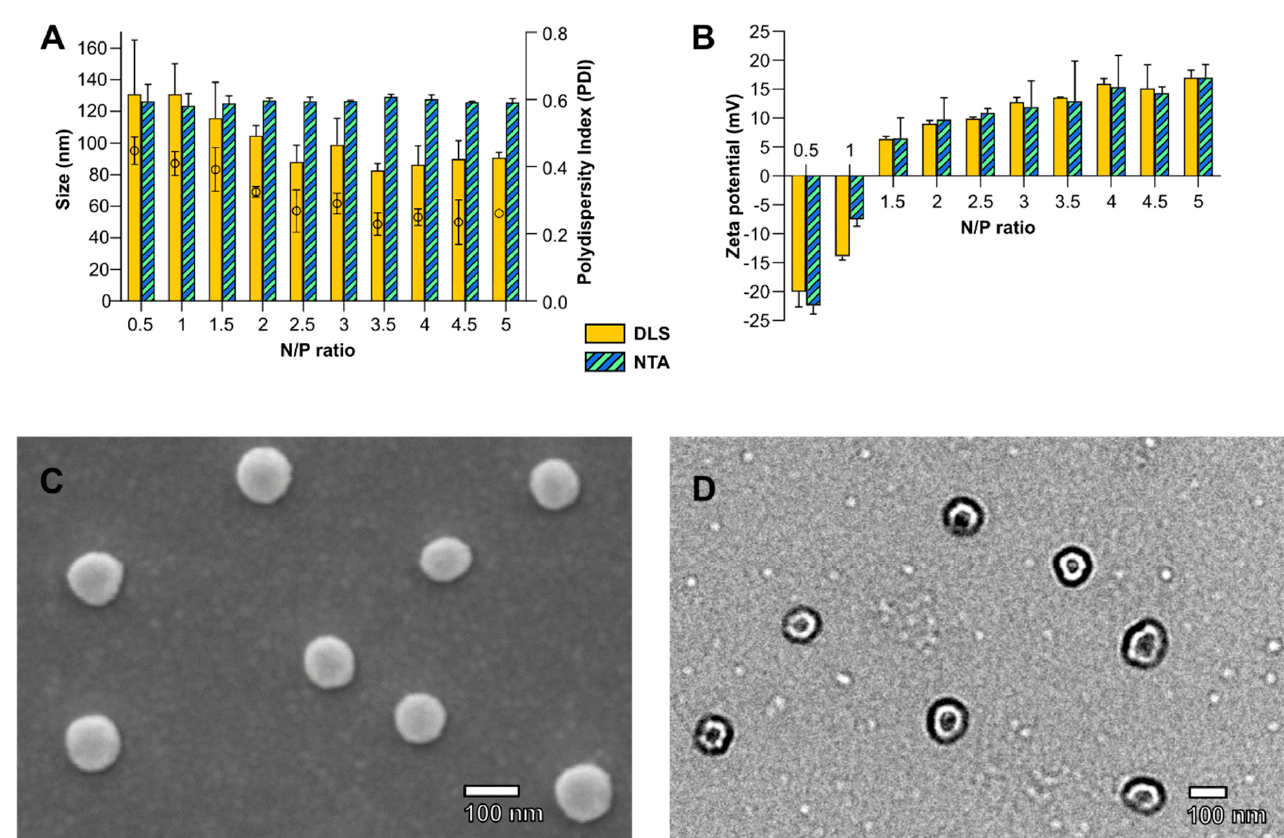
Figure 1. ( A ) The particle size/polydispersity index (PDI) and ( B ) zeta potential of siRNA micelle- plexes as determined by the intensity of dynamic/electrophoretic light scattering (yellow-filled bars) and the nanoparticle tracking analysis (hatched bars) at an N/P ratio varying from 0.5 to 5. PDI is represented by ○ . Error bars are the standard deviation (SD) of triplicates. Typical images at N/P = 3 by ( C ) SEM and ( D ) TEM.